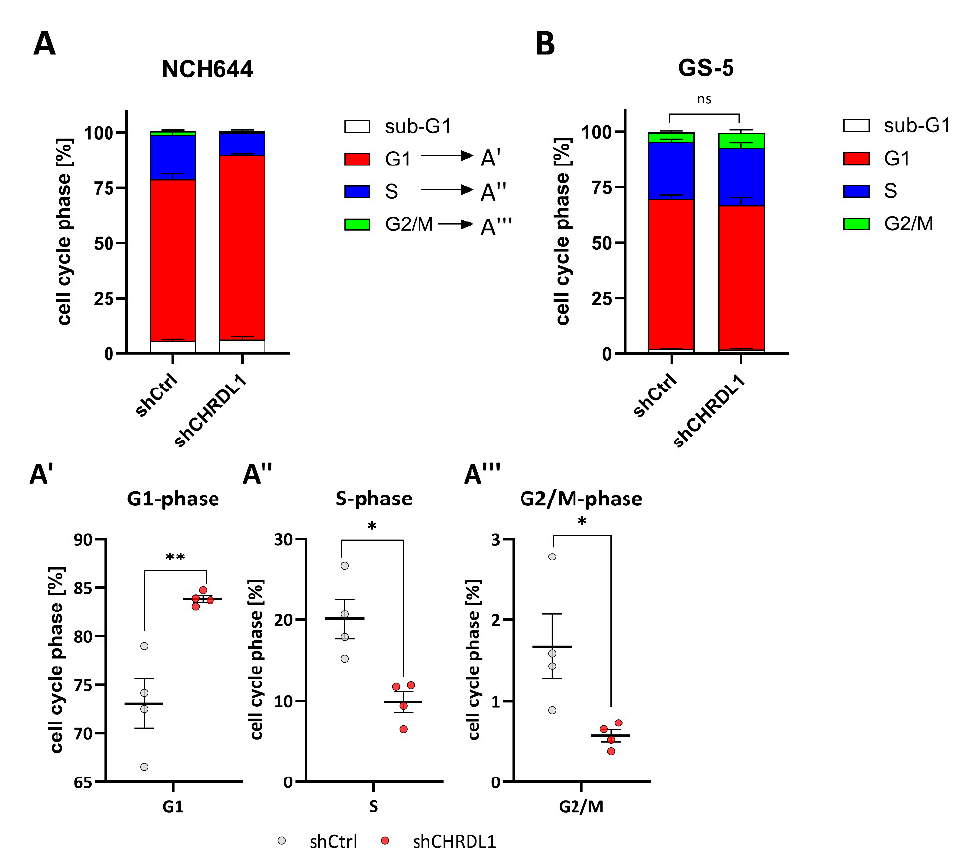
Figure 2. Cell cycle distribution of GSCs after CHRDL1-depletion. ( A , B ) Stacked bar graph of ( A ) NCH644 and ( B ) GS-5 after stable transduction with a non-targeting shRNA (shCtrl) or specific shRNA targeting CHRDL1 (shCHRDL1). After 24 h of seeding the cells, the cell cycle distribution was analyzed. For NCH644 GSCs a significant increase in cells in ( A ′ ) G1-phase with a concomitant significant decrease in ( A ″ ) S- and ( A ‴ ) G2/M-phases was observed. The experiment was performed using biological quadruplicates. * p < 0.05; ** p < 0.01; ns: not significant; unpaired t test. Similar to NCH644, we analyzed the same gene panel for GS-5 GSCs (Figure 4)